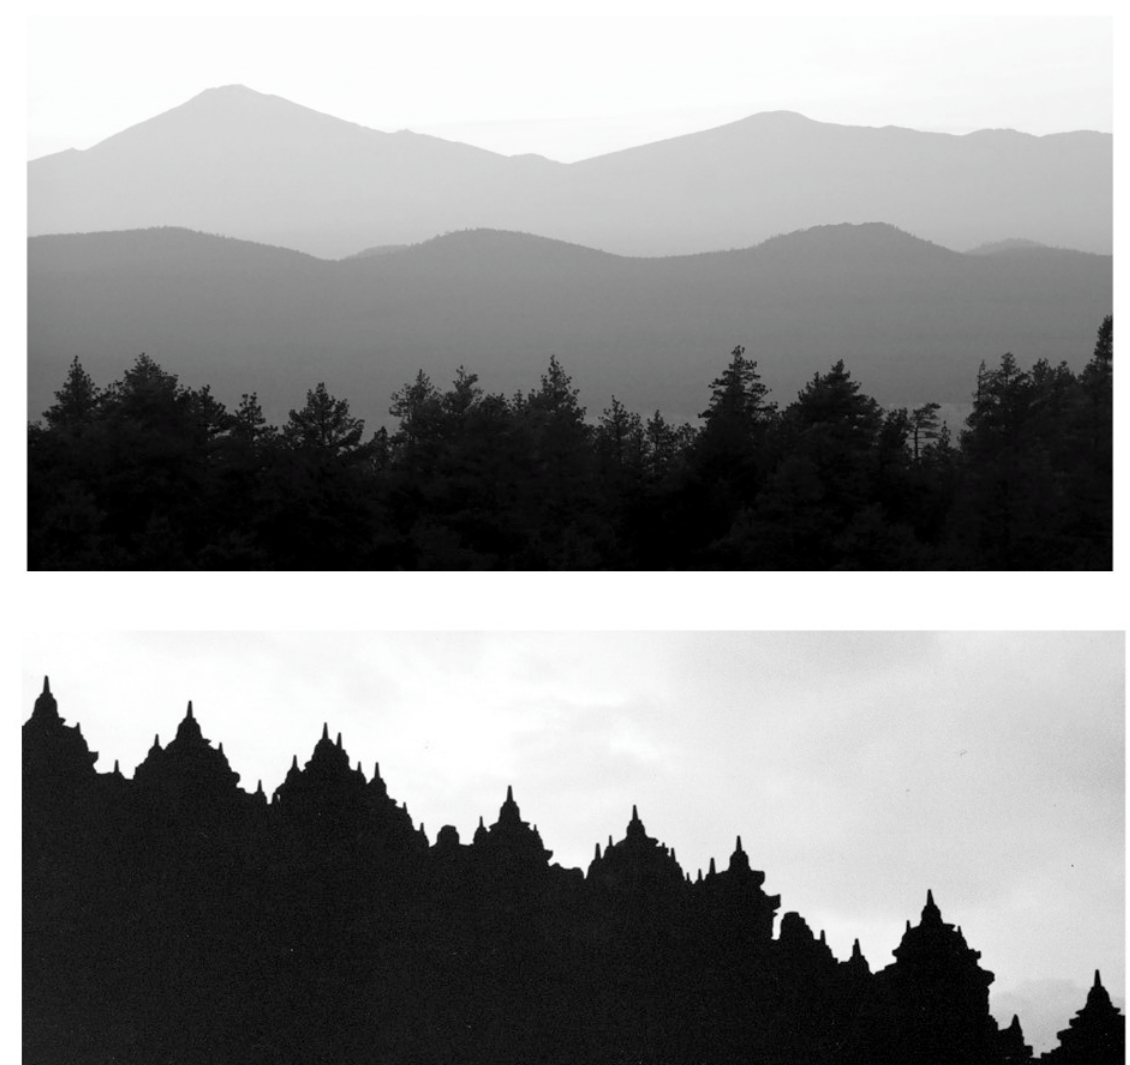
Figure 4. The top image shows several examples of natural fractal profiles with low (hill) and high (trees) D values. Fine structure contributes to the fractal pattern generated by trees making it much greater than for hills, which leads to a higher D value. The image below shows an example of a similar profile in buildings. Traditional architecture, such as the Borobudur Temple in Indonesia, features mid ‐ D fractal profiles. Figure and photo by R. P.